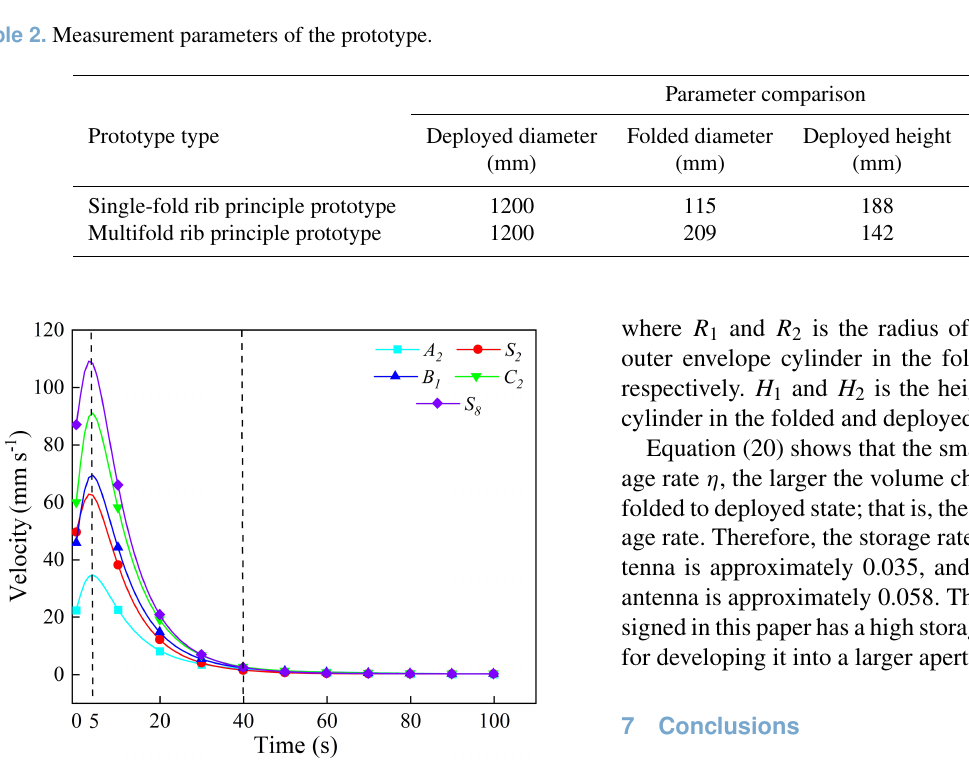
Figure 17. Velocity curve.